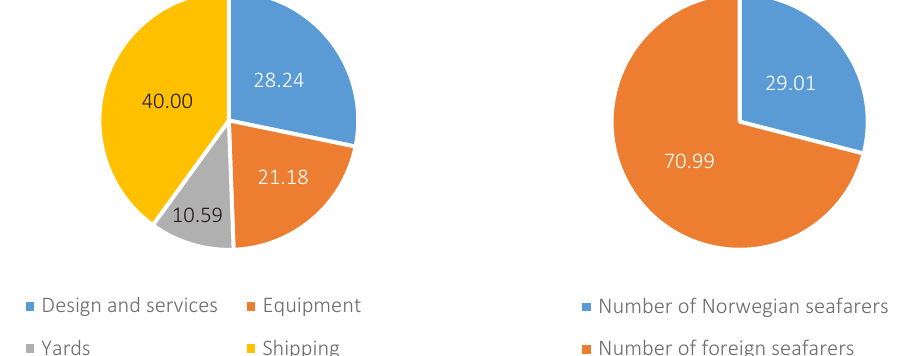
Figure 5. Number of persons employed in the maritime industry in 2018 by main groups, %